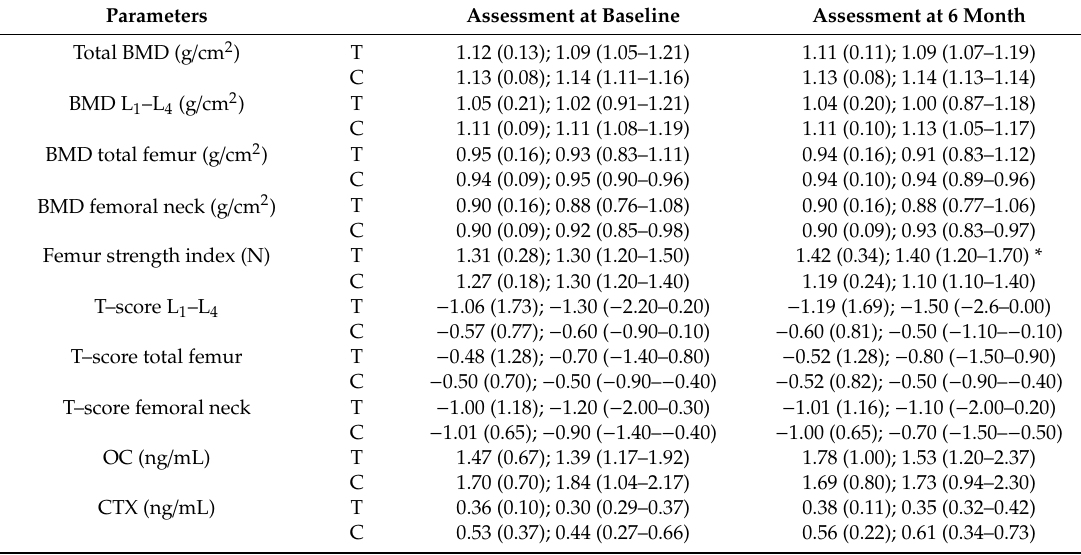
Table 2. Areal bone mineral density, femur strength index and bone turnover markers before and after the intervention in the training and control